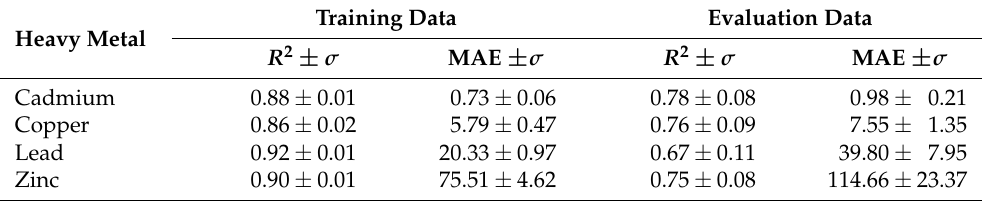
Table 5. Combined spatial interpolation and prediction model via Gaussian